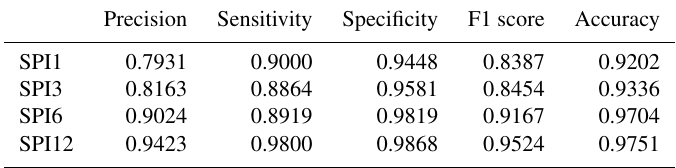
Table B1. NN metrics median value of the top 5% configuration according to F1 score.